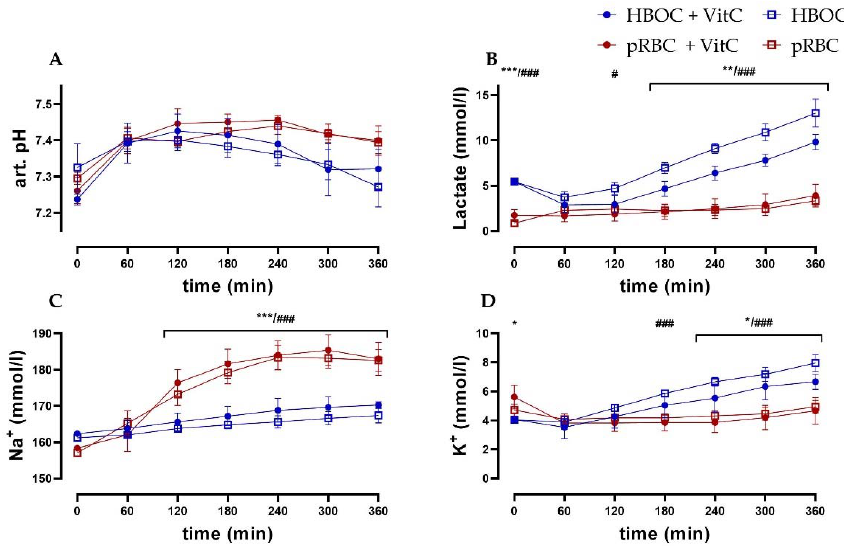
Figure 4. ( A ) Arterial pH, ( B ) lactate, and ( C ) perfusate sodium concentrations were significantly higher in the pRBC groups vs. the HBOC groups from 120 min onwards and ( D ) potassium concen- trations remained significantly lower after 180 min (pRBC vs. HBOC; # p < 0.05, ### p < 0.001) and 240 min (pRBC + VitC vs. HBOC + VitC; * p < 0.05, ** p < 0.01, *** p < 0.001). 240 min (pRBC + VitC vs. HBOC + VitC; * p < 0.05, ** p < 0.01, *** p <